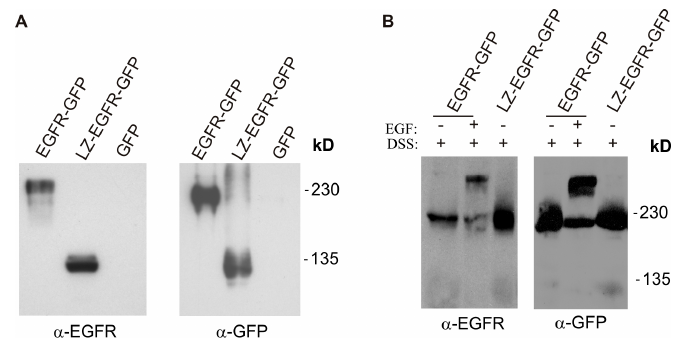
Figure 2. Cont. Figure 2.